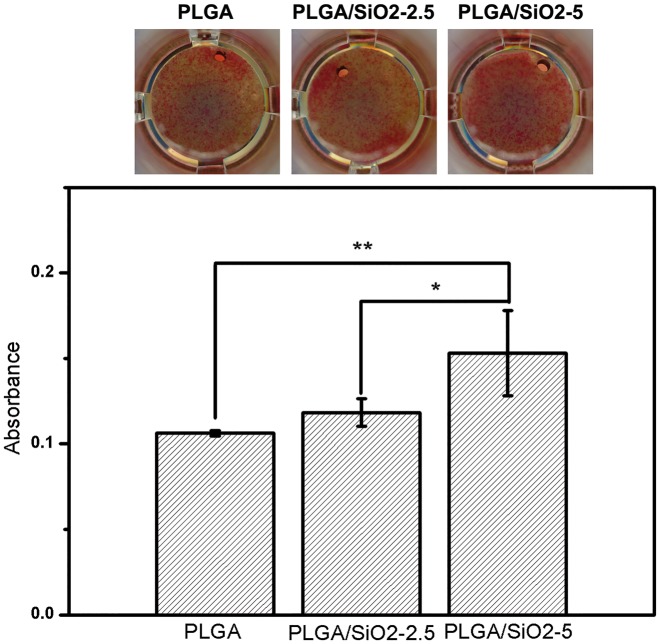
Sirius red staining used for the visualization of collagen deposition and the quantitative result after 10 days of culture on each fibers. Values are expressed as mean ± SD (n = 3 for each sample, *P < 0.05 and **P < 0.01)